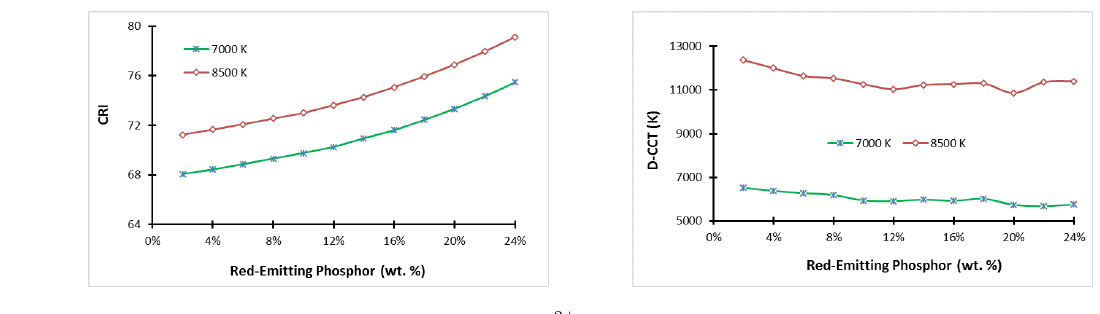
Fig. 5: Scattering coe(cid:30)cients of α -SrO · 3B 2 O 3 :Sm 2+ versus concentration red phosphor (%)